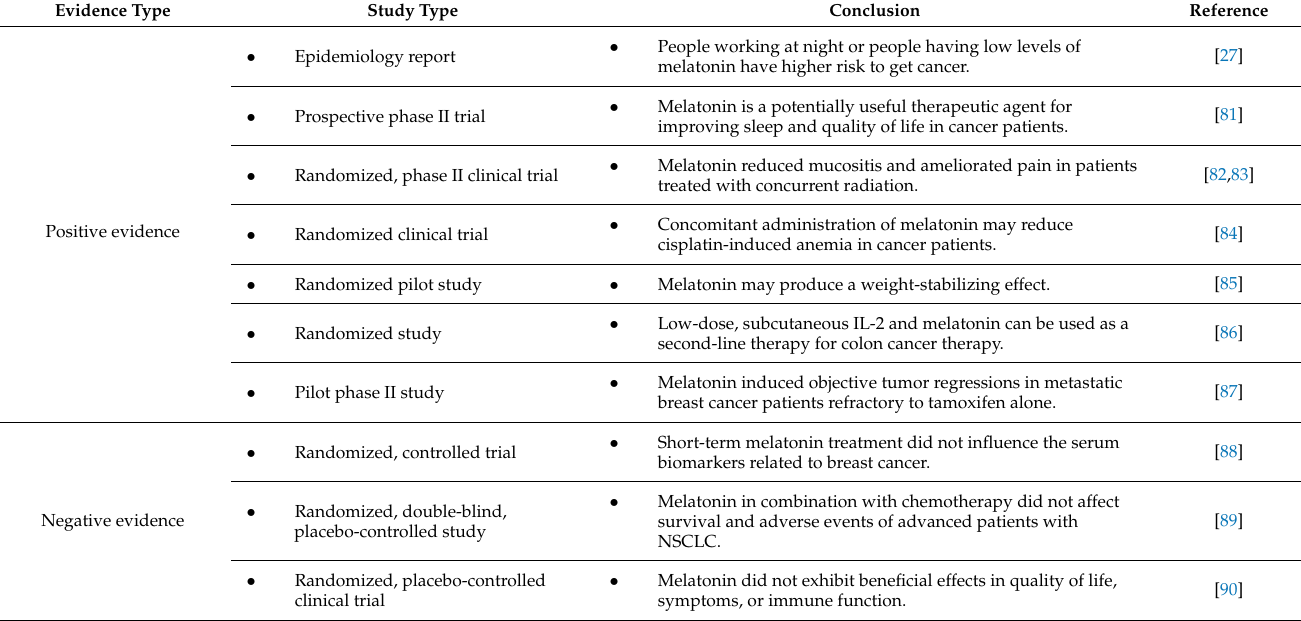
Table 1. Clinical evidence for the anticancer effects of